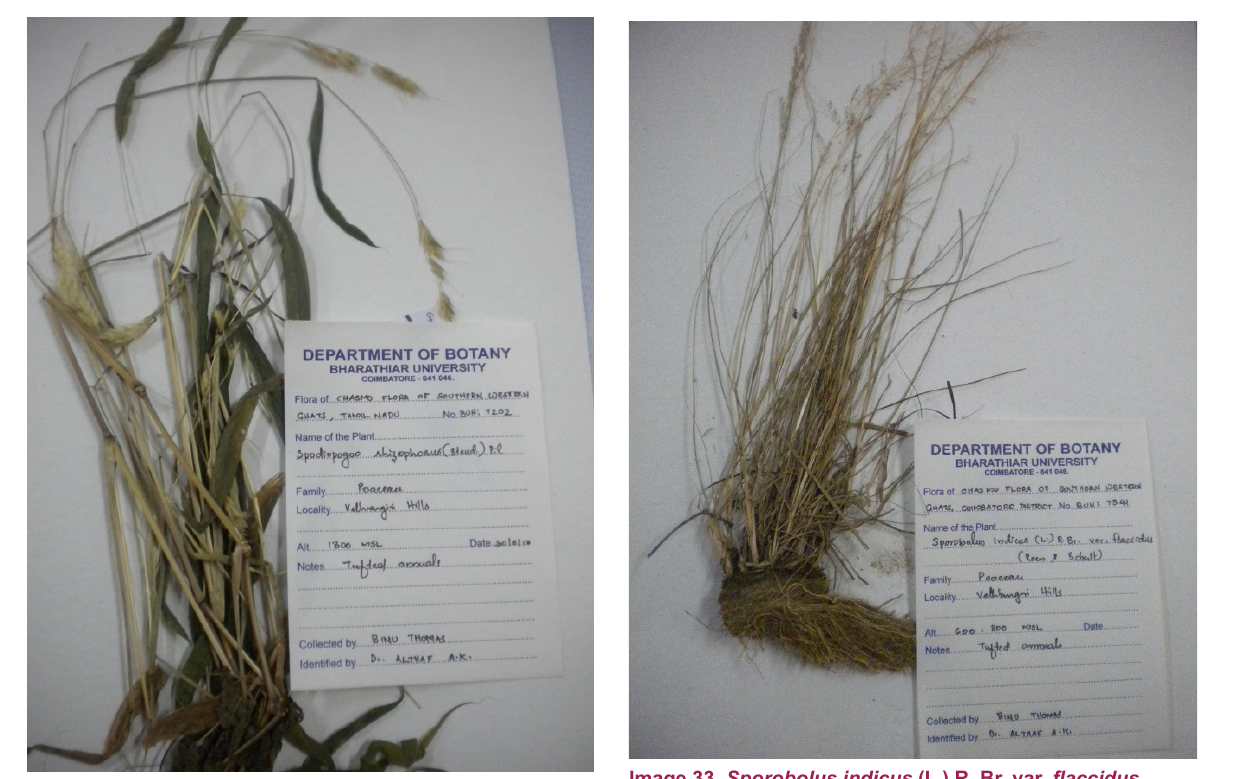
Image 32. Spodiopogon rhizophorus (Steud.) Pilger